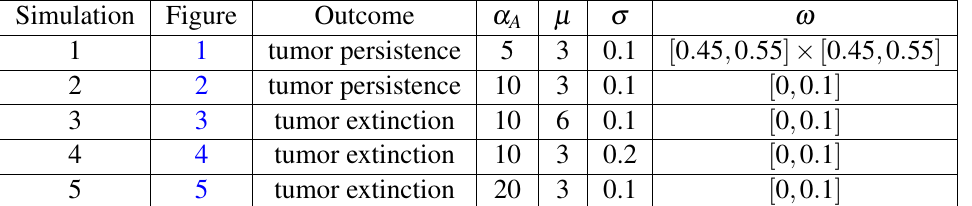
Table 1 Set-up of different simulations an their biological outcomes. Each row indicates the numerical values used for the chemotherapeutic parameters α A (cytotoxicity), σ (diffusion coefficient), µ (infusion rate), and the position of ω ⊂ Ω ⊂ R 2 . Simulation 1 was performed in a two-dimensional domain Ω = [ 0 , 1 ] × [ 0 , 1 ] , while simulations 2-5 were performed in a one-dimensional domain Ω = [ 0 , 1 ]